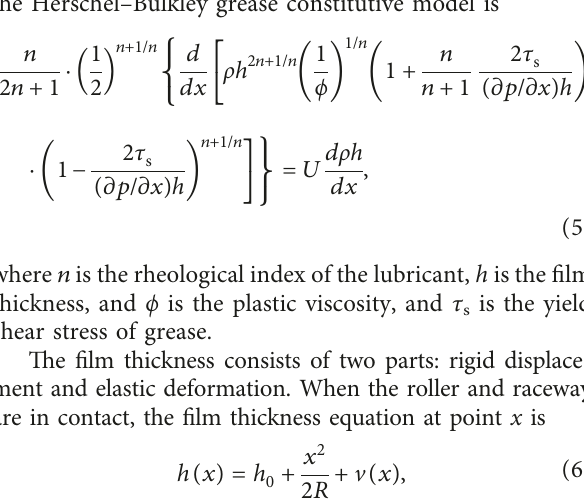
Figure 3: Equilibrium of an element.